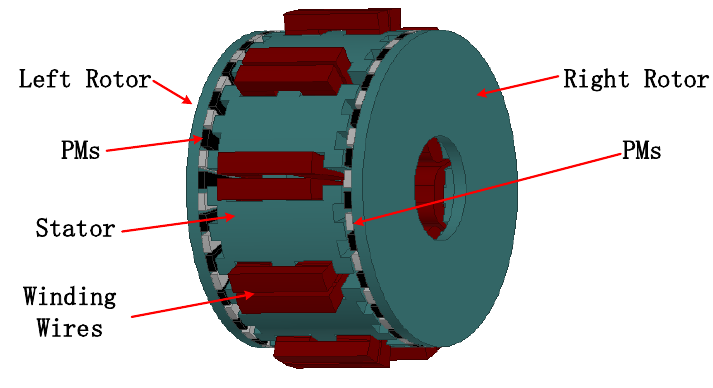
Figure 1. Structure of the proposed machine.